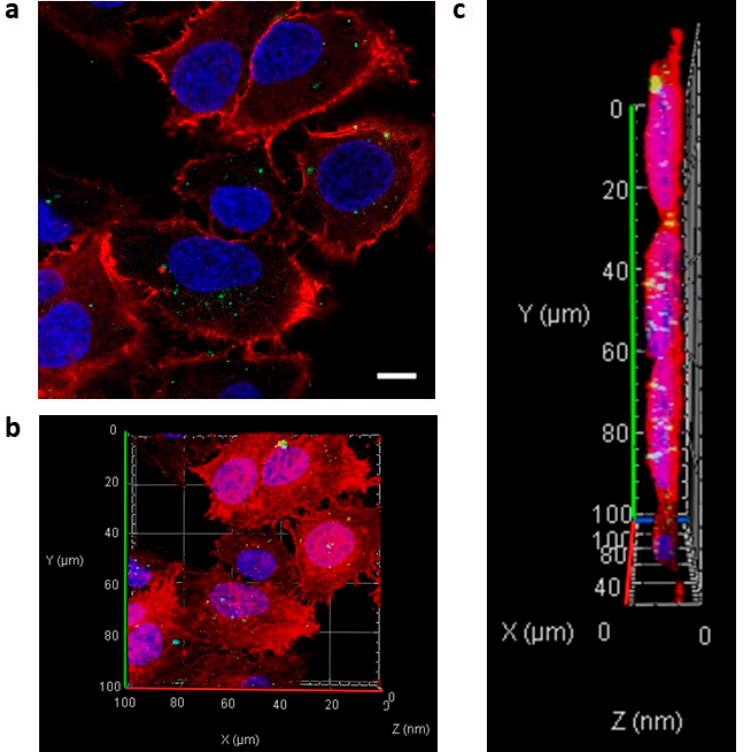
Figure 4. Effective transfer of anti-CD63 mAb-linear Arg conjugated with siRNA complexes into HeLa cells. The anti-CD63 mAb-Arg linear linker:siRNA ratio was 5:1 (1500:300 (nM)). Fluorescence-labeled siRNAs were successfully transferred into HeLa cells. ( a ) Confocal image of HeLa cells containing anti-CD63 mAb-linear Arg conjugated with siRNA complexes: green dots, FITC-labeled siRNAs; red, rhodamine-phalloidin; blue, Hoechst 33342. Scale bar, 20 µ m. ( b , c ) Reconstructed Z-stack images of HeLa cells. White dots, incorporated siRNAs.